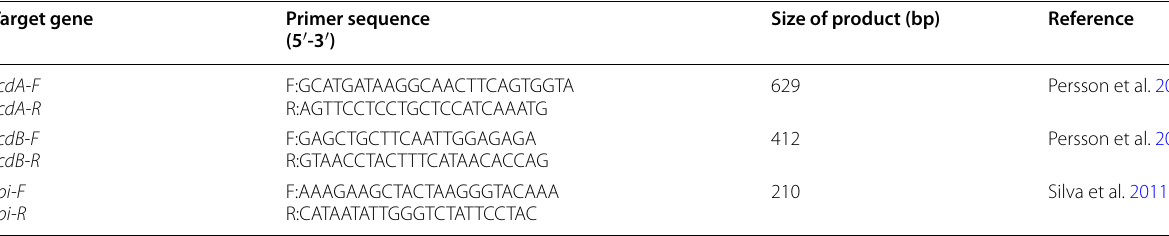
Table 1 The sequences of special primers for the tcdA, tcdB and tpi genes Target gene